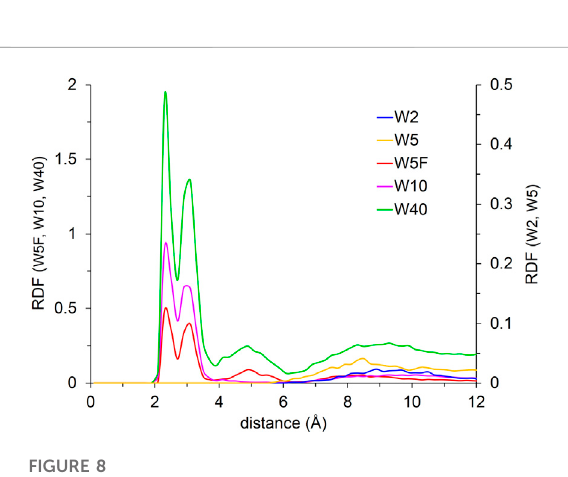
FIGURE 8 RDF for water molecules with respect to Na + . W2 and W5 systems are presented on the right axis, systems of W5F, W10, and W40 are presented on the left axis. In this work, the RDFs are scaled by appropriate number densities to facilitate the comparison across systems with different water/IL